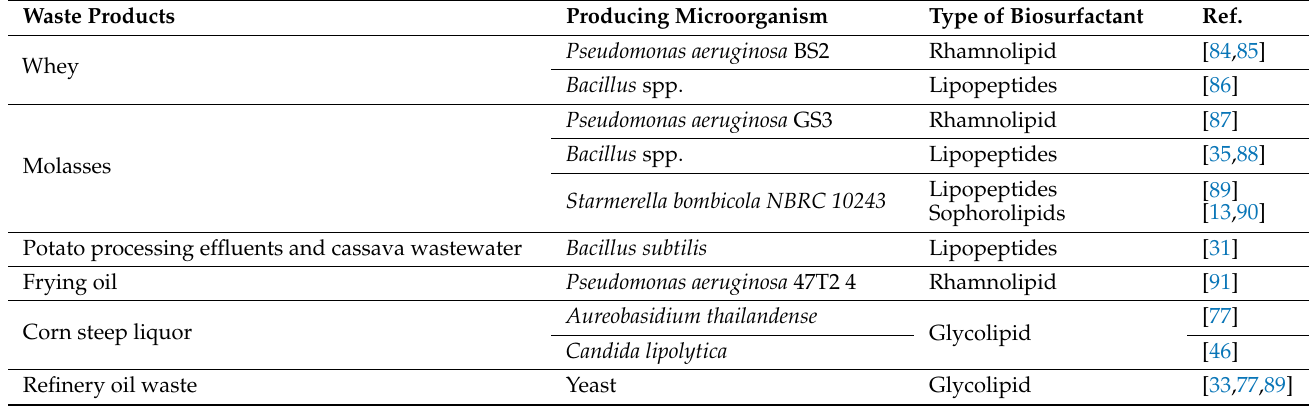
Table 1. Different residues used in the production of biosurfactants by different microorganisms. Waste